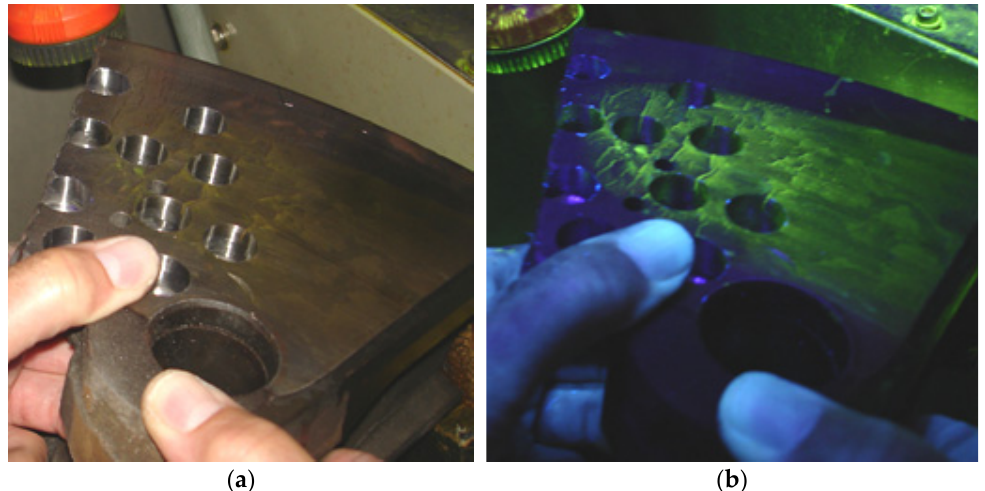
Figure 8. View of the brake disc section 610 mm × 110 mm: ( a ) before magneto-particle tests, ( b ) during tests.